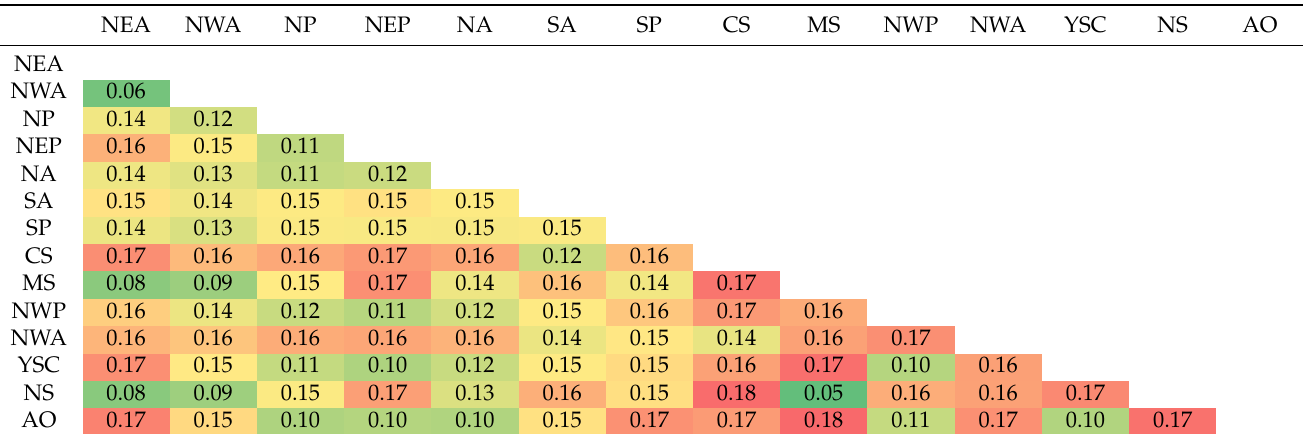
Table 2. Pairwise genetic distance Kimura’s two-parameter model (K2P) values (per site) among Pagurus species between geographic groups based on combined (16S + COI)